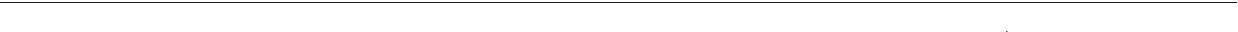
Fig. 3 CKAMP44 decreases fi ring probability of dLGN neurons. a EPSP amplitudes increase more in neurons of CKAMP44 − / − than in those of wildtype mice. EPSPs were evoked with a train of ten stimuli at 50 Hz (wildtype: n = 18, CKAMP44 − / − : n = 25, mean ± SEM, fi rst and second EPSP amplitude: t -test, others: Mann – Whitney test). Example traces are shown in the middle, the quanti fi cation of the EPSP amplitudes on the right. b Spike probability during a 10 × 50 Hz stimulus is increased in CKAMP44 − / − mice (wildtype: n = 11, CKAMP44 − / − : n = 10). Example traces and raster plots of action potentials during ten repetitions of the stimulus train are shown on the left. The spike probability (middle) for stimulus 4 – 10 and the fi ring rate during the entire stimulus train (right) is increased in CKAMP44 − / − mice. Note that the stimulation intensity was adjusted such that the amplitude of the fi rst EPSP was 48% smaller in neurons of CKAMP44 − / − than in those of wildtype mice. (mean ± SEM, amplitude of responses 1 – 3: t -test, others: Mann – Whitney test). c – e Deletion of CKAMP44 increases spike probability and fi ring rate during a 10 × 50 Hz stimulus following a ×40 stimulation at 1 Hz ( c , wildtype: n = 27, CKAMP44 − / − : n = 33), 3.3 Hz ( d , wildtype: n = 20, CKAMP44 − / − : 32), and 10 Hz ( e , wildtype: n = 21, CKAMP44 − / − : n = 27) (mean ± SEM, Mann – Whitney test). Example traces are shown on the left. The quanti fi cation (middle) shows that EPSP amplitudes during the ×40 stimulation train attenuate less and that fi ring probability is higher in relay neurons of CKAMP44 − / − mice than in wildtype mice. The amplitudes of the fi rst EPSPs are shown with dashed lines. Note that stimulation intensity was adjusted such that the amplitude of the fi rst EPSP was 42 – 46% smaller in relay neurons of CKAMP44 − / − than those in wildtype mice. Bar graphs (right) show the fi ring rate of relay neurons during the 200 ms stimulation. * p < 0.05, ** p < 0.01, *** p <